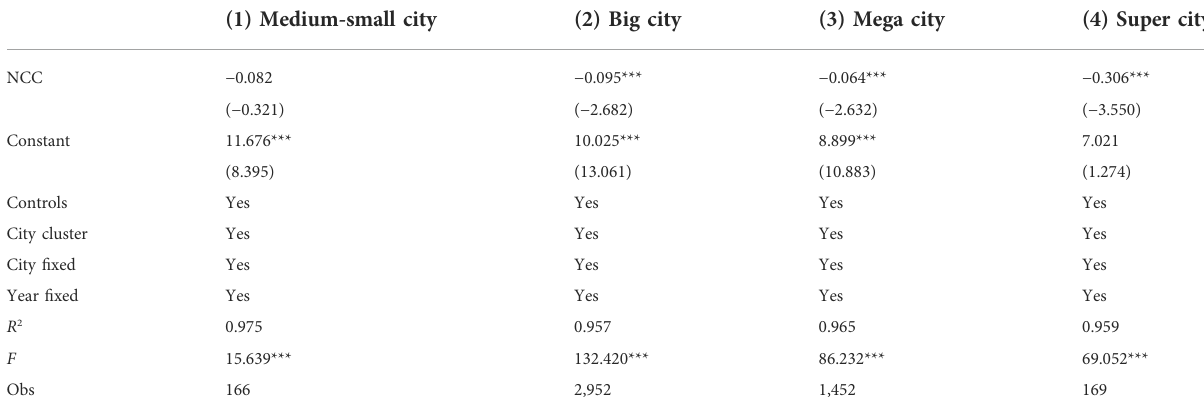
TABLE 8 Heterogeneity of urban population